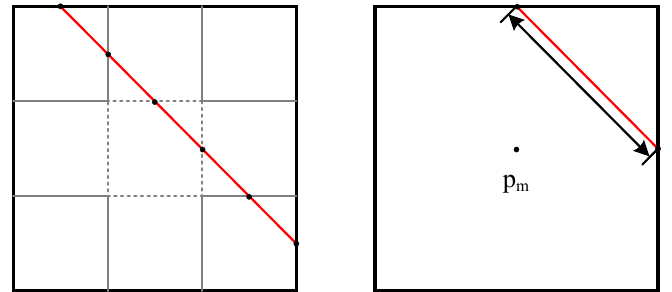
Figure 2. Flow exchange between matrix mesh and fracture mesh.